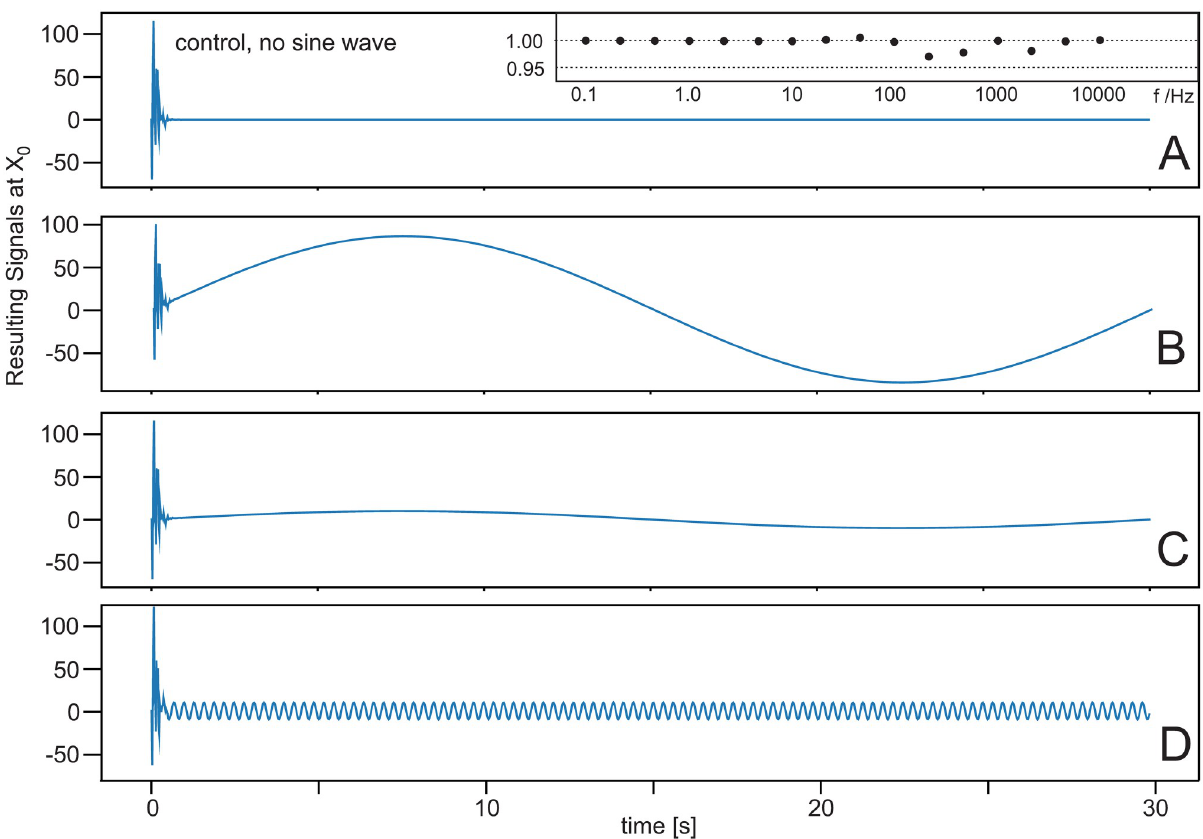
Fig 9. Influence of noise cancellation on a sine-wave signal. Geometrical configuration as in Fig 3. Learning rate: μ = 1.0 × 10 − 7 . A Control case without signal. B Sine wave with frequency 1/30 Hz and different amplitudes. C Same frequency as in B but amplitude reduced by a factor of 10. D Sine wave with frequency 100/30 Hz . The inset shows the ratio between the signal provided at x 0 without noise and the signal obtained after filtering the noise with ICO for a large range of frequencies.